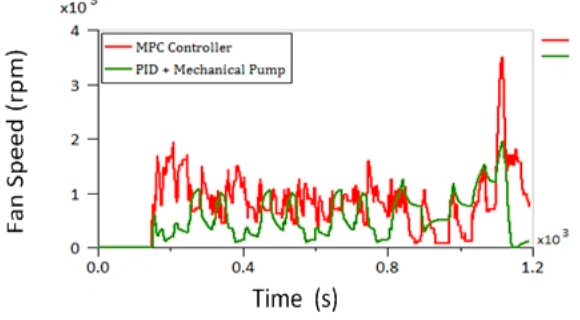
Figure 18. Comparison of the fan speed.